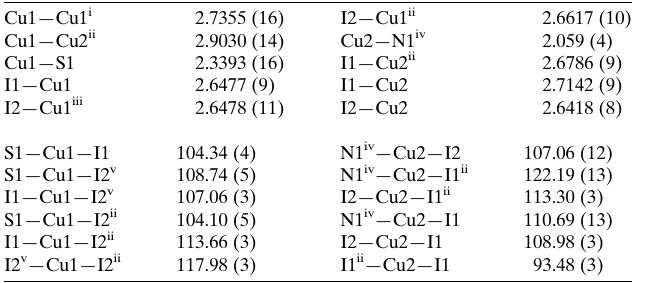
Table 2 Hydrogen-bond geometry (A˚ , (cid:5) ).